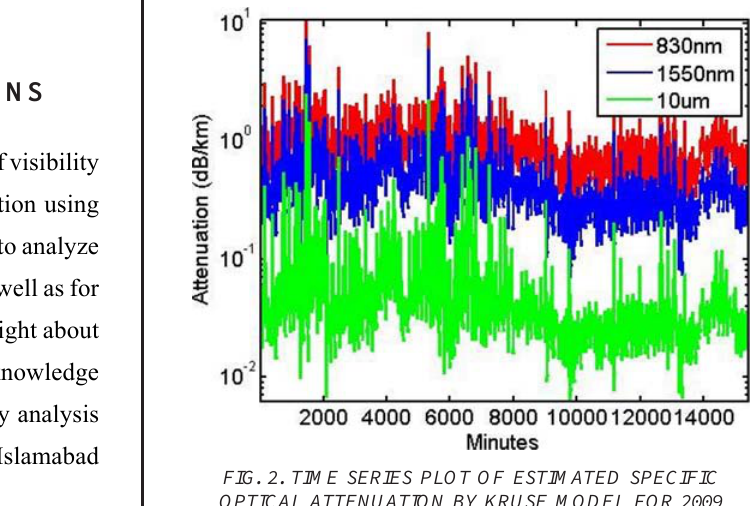
FIG. 2. TIME SERIES PLOT OF ESTIMATED SPECIFIC OPTICAL ATTENUATION BY KRUSE MODEL FOR